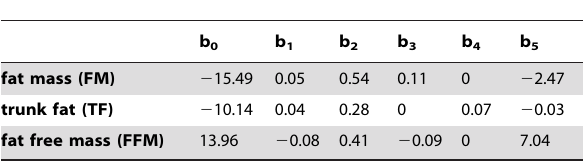
was related to FFM inversely and to TF in a positive manner. The lack of correlation of age with other anthropometric variables suggests that there are other variables not accounted for by the model, e.g., possibly age-related differences in metabolic rate. Regional fat distribution did weakly correlate with FM as increases